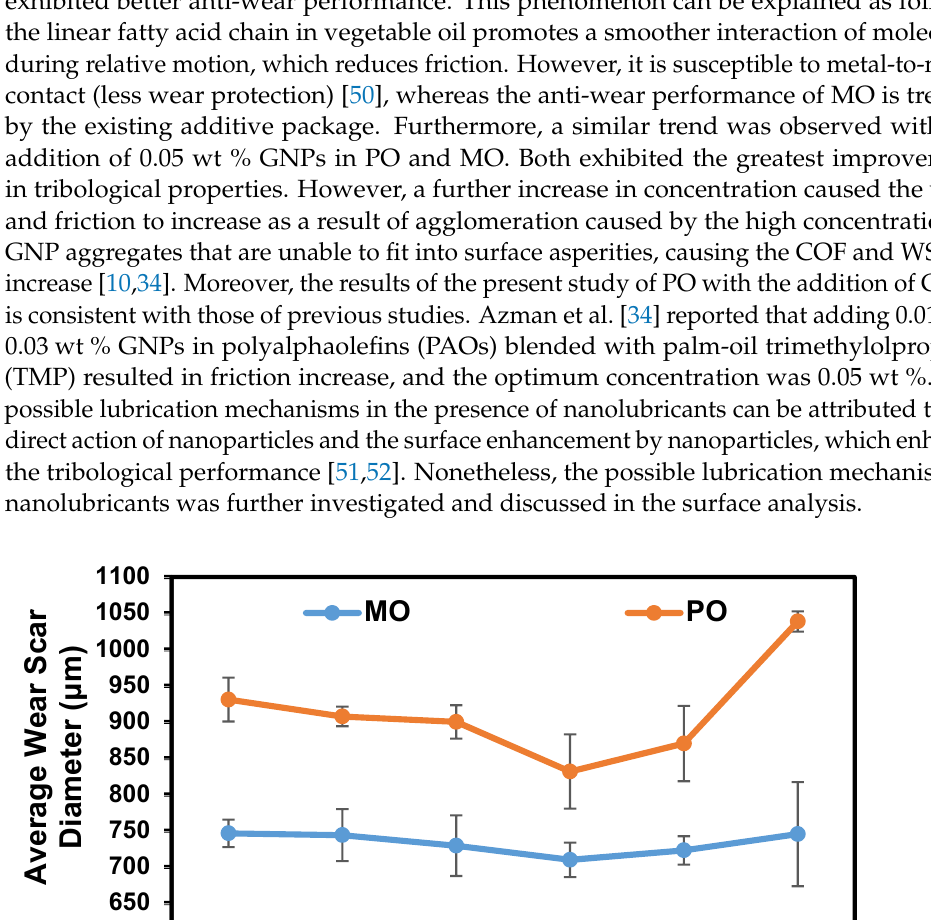
Figure 5. The WSD results achieved using both PO and MO oils with different GNPs concentrations (0 to 0.2 wt %).